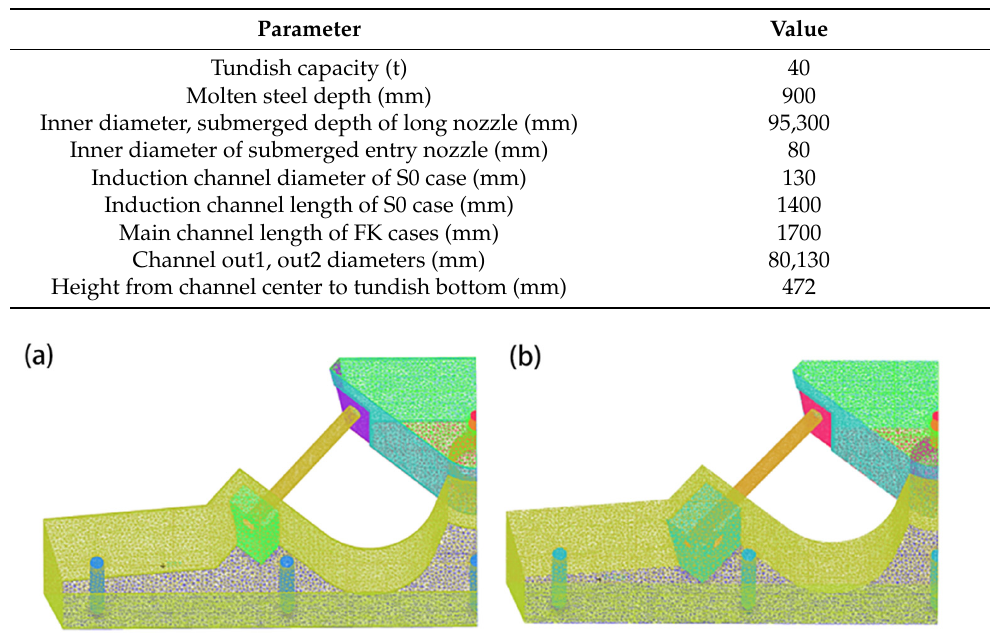
Figure 2. Schematics of the model in grids: ( a ) Case S0; ( b ) Case FK-A0.